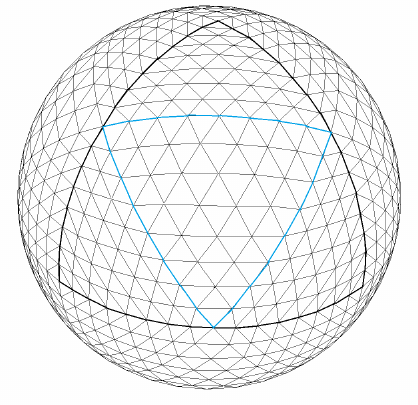
Figure 1. Schematic diagram of level 3 QTM.